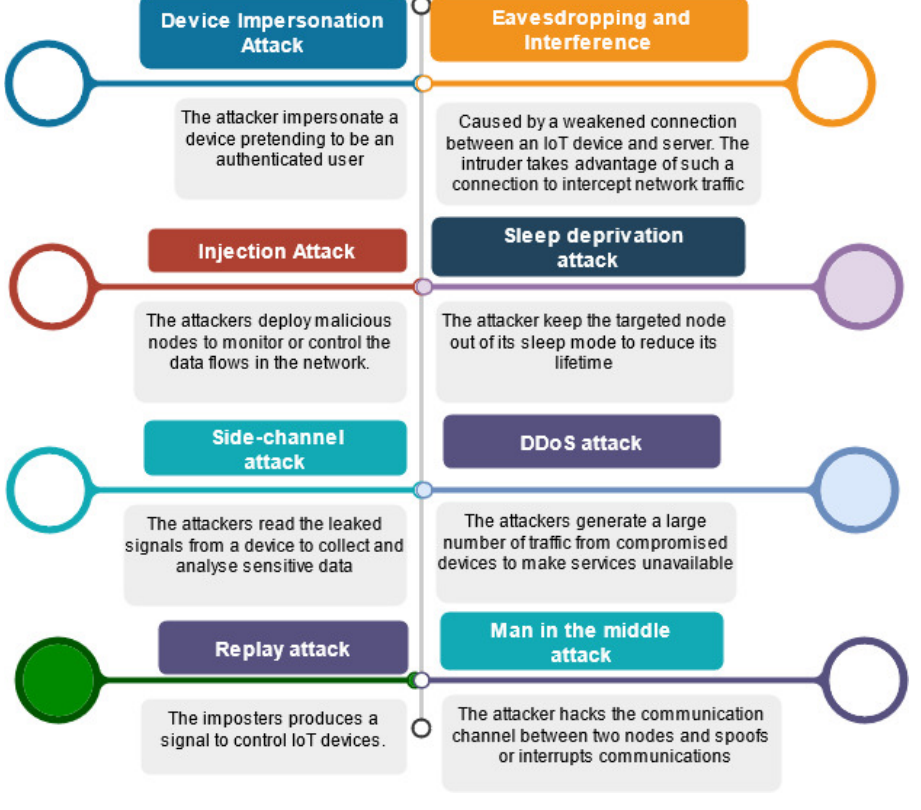
Figure 4. IoT Network